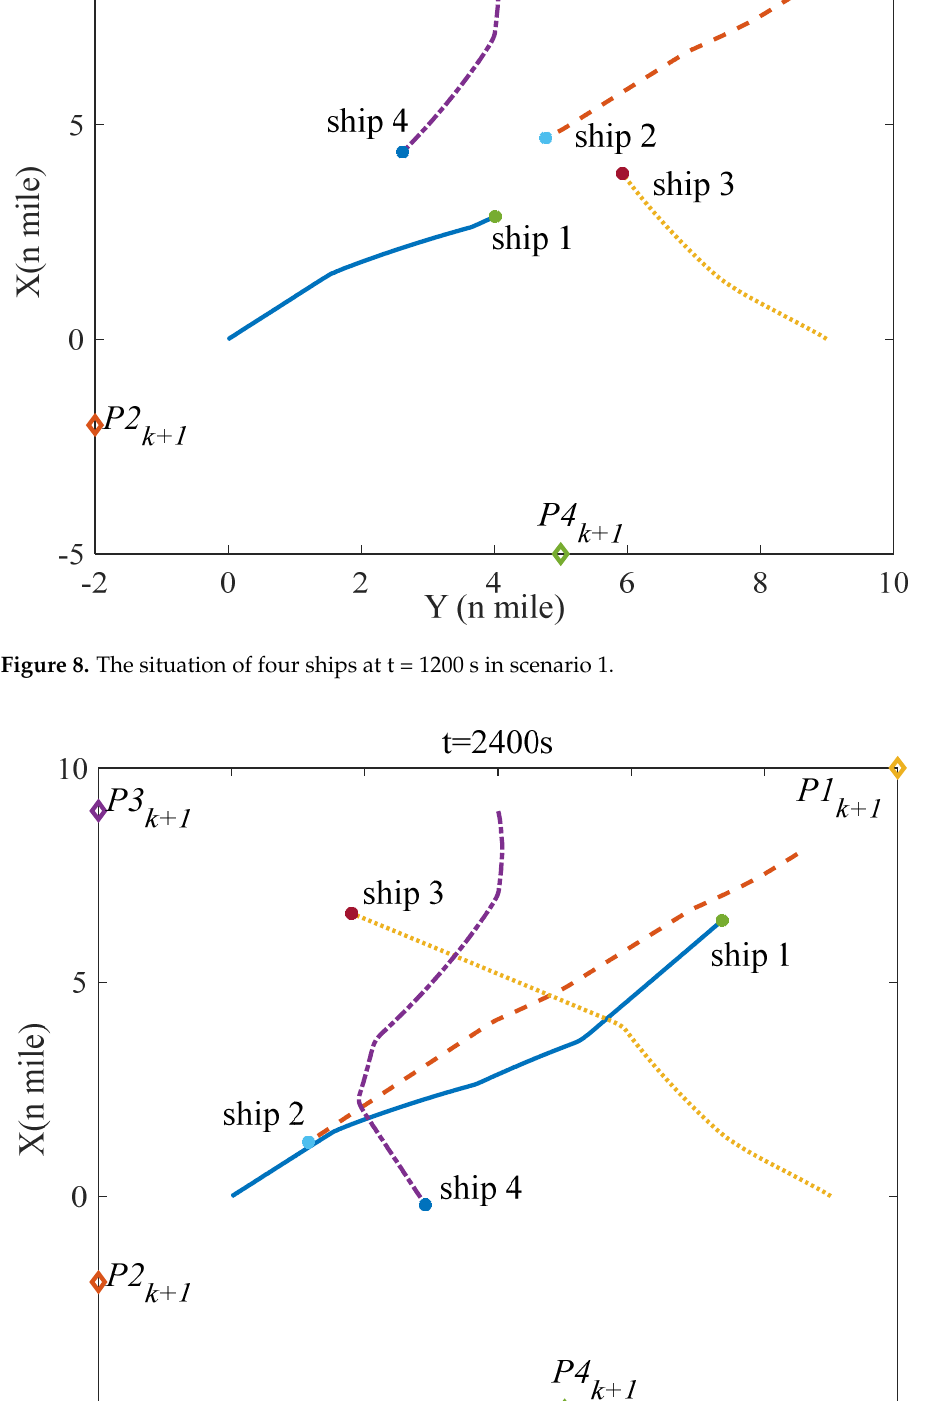
Figure 9. The situation of four ships at t = 2400 s in scenario 1.